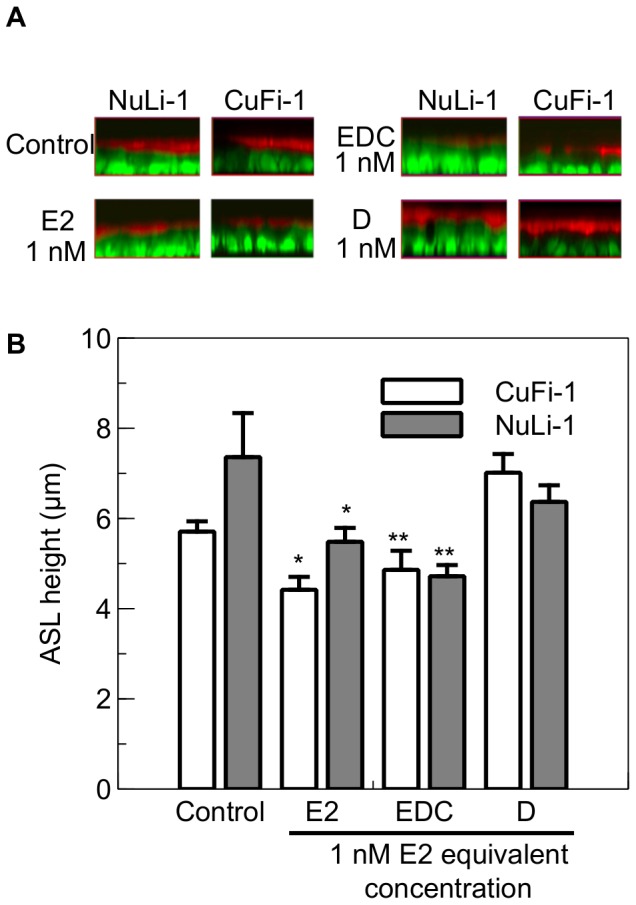
Effect of the Estrogen Dendrimer Conjugate on ASL height.NuLi-1 and CuFi-1 epithelial monolayers were treated with 1 nM E2, or EDC at concentrations providing 1 nM estrogen equivalents, or empty dendrimer at the concentration that matched that in EDC at a 1 nM estrogen equivalent. Panel A shows typical z-plane sections in control conditions or after treatment with E2, EDC or the empty dendrimer (D). The concentrations given for the EDC and the empty dendrimer are in equivalent E2 concentrations. Panel B shows the mean changes in ASL height in control conditions or following exposure to E2, EDC or the empty dendrimer (n≥4, Error bars reflect standard error of the mean, ANOVA, * p<0.05, ** p<0.01).